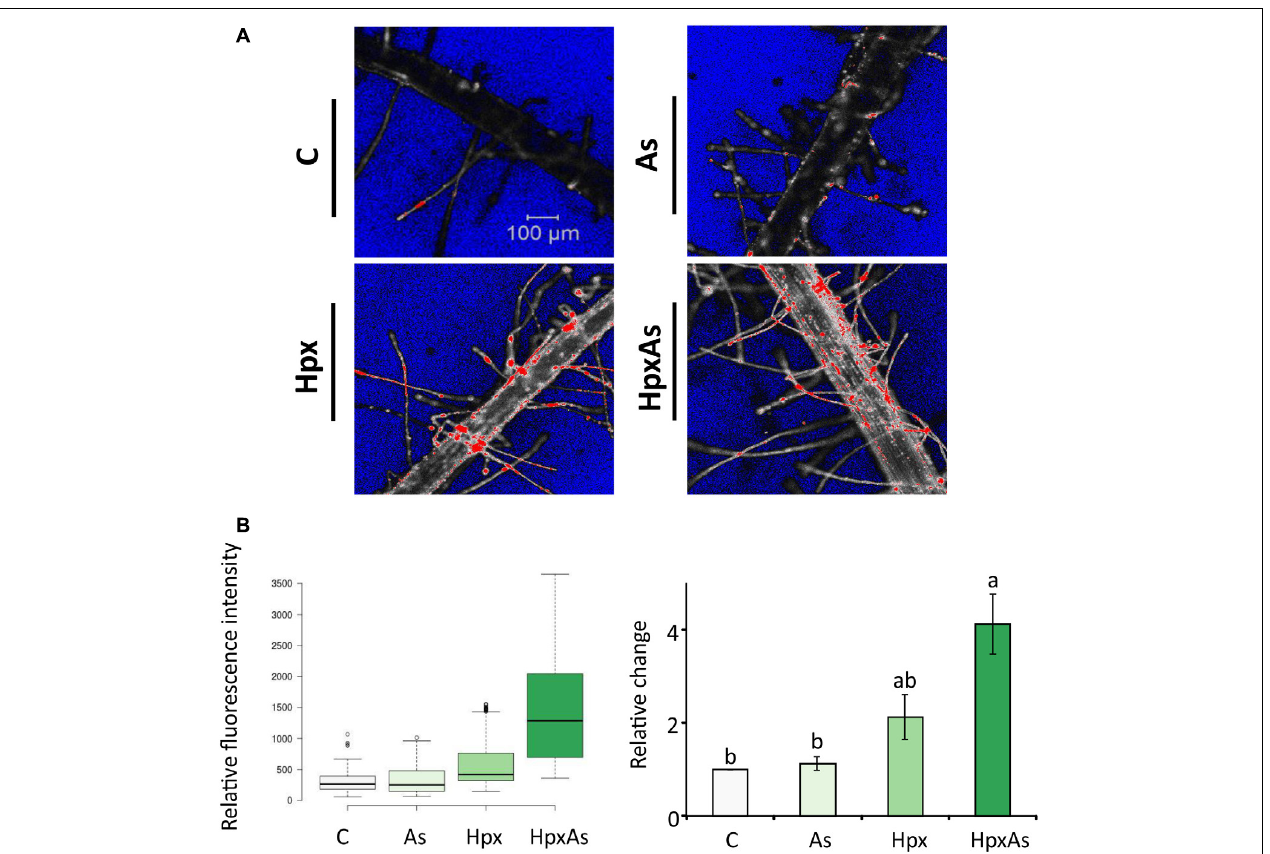
FIGURE 4 | In vivo fluorescence analysis for cell non-viability in the root hair zone of As-, Hpx-, and HpxAs-treated Arabidopsis roots. SYTOX green fluorescent probe was used to label non-viable root cells in the RH zone. The roots were exposed to different stresses for 7 days, labeled with SYTOX for 7 min on the last day of treatment and imaged under the confocal laser scanning microscope (LSM780, Zeiss). Fluorescent dye was excited using an argon laser (488 nm) and emission recorded in the range of 500–550 nm. (A) The micrographs display the fluorescence of SYTOX green (emission maximum at 523 nm) representing non-viable cells in the RH zone among different applied stresses after 7 days of treatment. The micrographs present fluorescence data in grayscale with added range indicators (Blue; background, Red; fluorescence oversaturated regions) (B) Recorded fluorescence intensities were compared for the stresses and are presented as box plot (shiny.chemgrid.org/boxplotr) (left). Center lines show the medians; box limits indicate the 25 th and 75 th percentiles as determined by R software; whiskers extend 1.5-times the interquartile range from the 25 th and 75 th percentiles; not connected data points represent outliers. Histogram on the right shows relative changes in SYTOX fluorescence intensity for the treatments compared to control. The data are means ± SE, n = 3 (data collected from 3 independent experiments over 250–260 individual RH areas from multiple plants; Tukey’s test, p < 0.05). For quantitative fluorescence analysis, saturated areas of the micrographs were